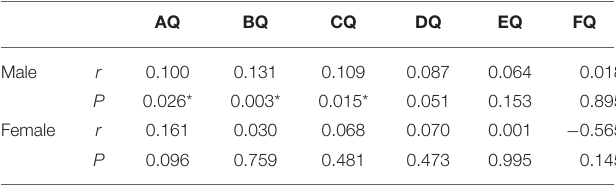
TABLE 5 | Correlation of menaquinone-4 levels and DQs in male and female subgroups. AQ BQ CQ DQ EQ